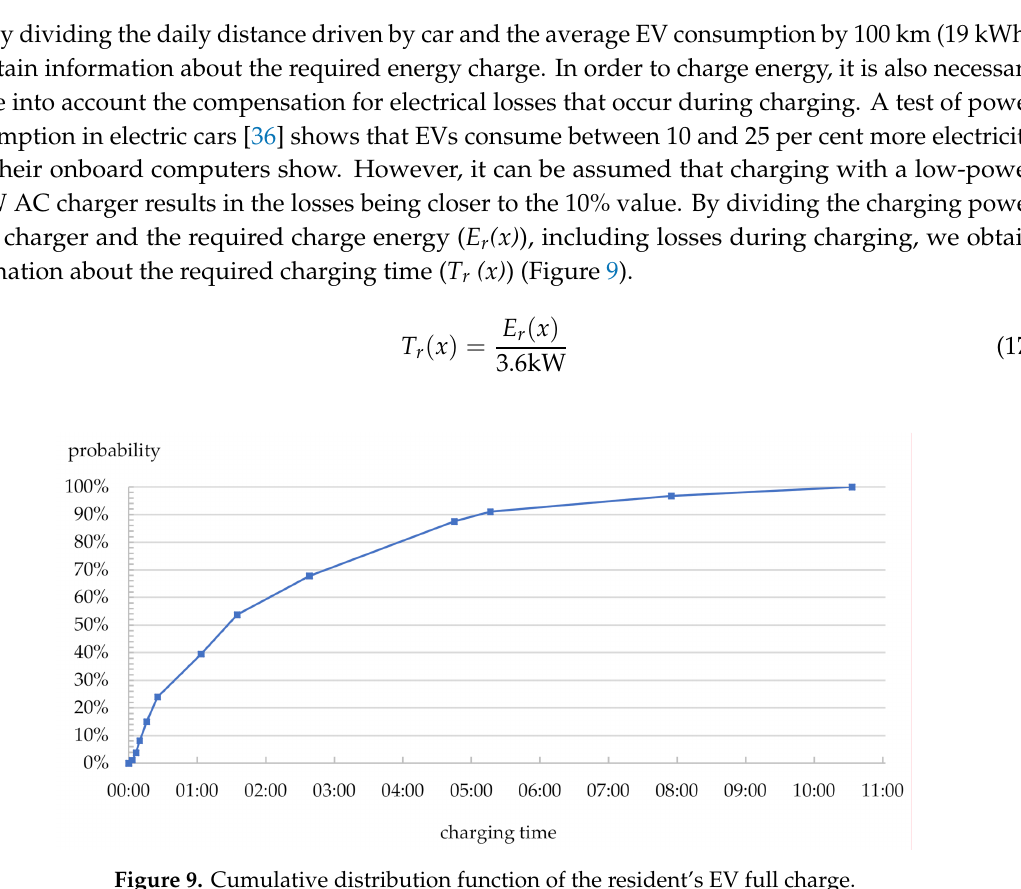
Figure 8. Probability density function of daily distance driven by car [35].